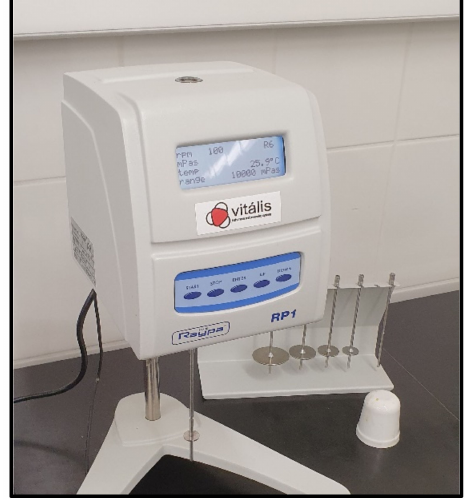
Figure 5. Raypa RP1 rotational